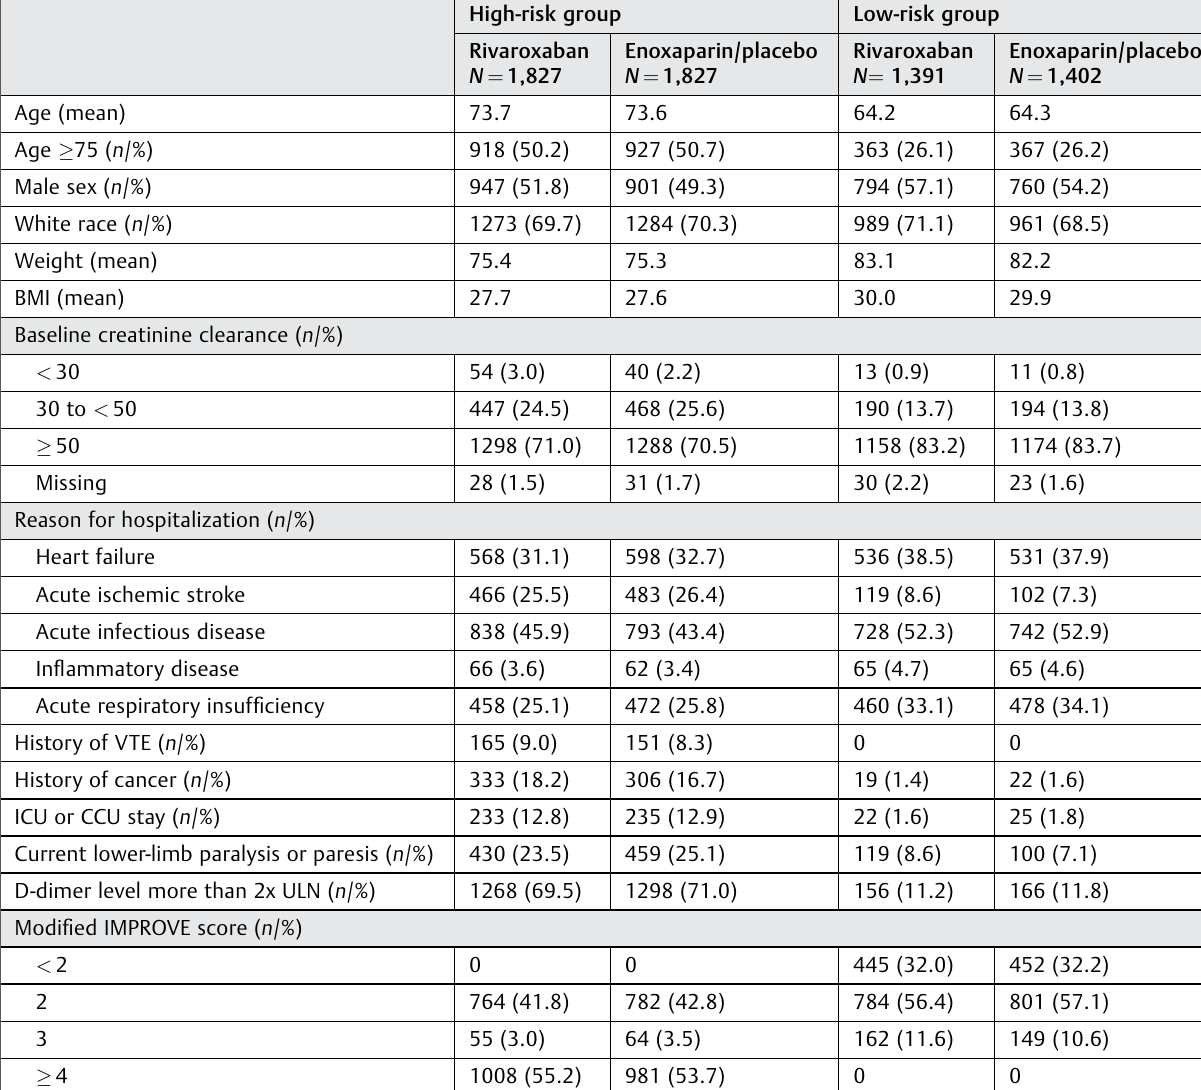
Table 2 Key baseline demographics (MAGELLAN subpopulation: safety analysis set) High-risk